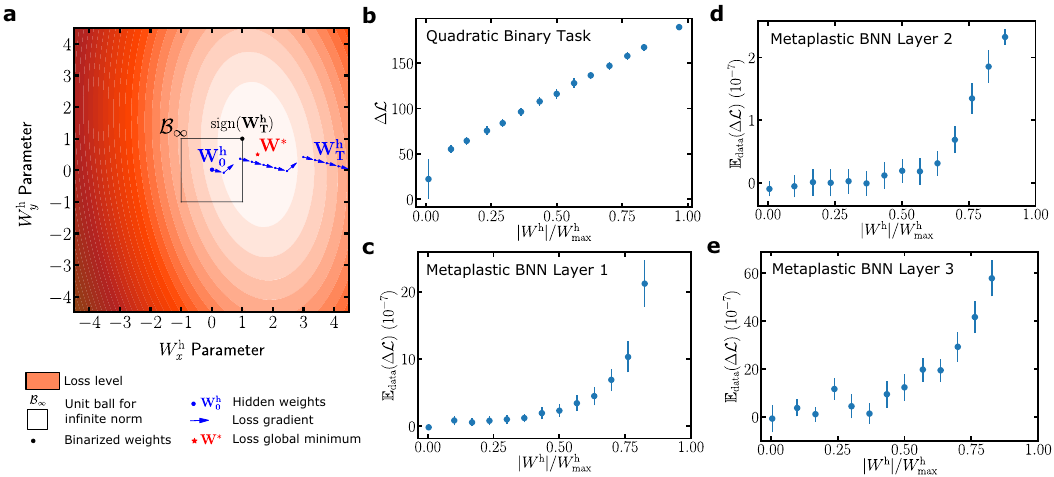
Fig. 6 Interpretation of the meaning of hidden weights. a Example of hidden weights trajectory in a two-dimensional quadratic binary task. One hidden weight W h x diverges because the optimal hidden weight vector W * has uniform norm greater than one (Lemma 2 of Supplementary Note 5). b Mean increase in the loss occurred by switching the sign of a hidden weight as a function of the normalized value of the hidden weight, for a 500-dimensional quadratic binary task. The mean is taken by assigning hidden weights to bins of increasing absolute value and the error bars denote one standard deviation around the mean. The leftmost point corresponds to hidden weights staying bounded. c – e Increase in the loss occurred by switching the sign of hidden weights as a function of the normalized absolute value of the hidden weight in a binarized neural network trained on MNIST. Each dot is the mean increase over 100 realizations of weights to be switched and the error bars denote one standard deviation. The scales differ because the layers have different numbers of weights and thus different relative importance. See “ Methods ” for implementation